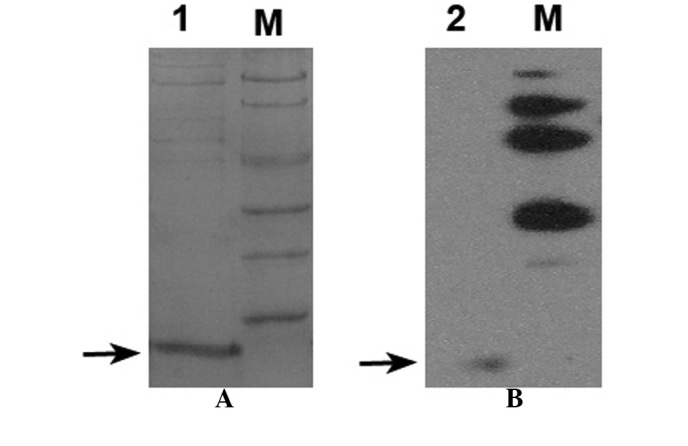
Mutated ISRAA gene. Mutated ISRAA was synthesized by site directed mutagenesis in which the predicted active site was deleted from the ISRAA gene, cloned in an pUC57 vector, protein was expressed in pQE32 vector, purified and then the activity of the mutated ISRAA was tested on hPBMCs. Protein sequence, isoelectric point (PI) and molecular mass (MW) are demonstrated as follows: PI/MW; 7.31/11955.0. Protein sequence: MRGSHHHHHHHGIRMAGETVLQGCPLCPDH AEGDRSPRIGGSQRQSPLLEVTHTQCCHLILSCLYVWCPVTQSLYGA PEQHSYTEVTSLQVIRILVNPSESANCLGKL. SDS-PAGE analysis of the mutated protein: (A) Lane 1, SDS-PAGE (4–20% gradient gel) of ISRAA-mutant protein (3 μg). (B) Lane 2, western blotting checking the mutated protein using anti-His antibody. Arrows indicate 11.955 kDa, the mutated protein on the SDS-PAGE and western blot analysis. Wild type ISRAA = 15 kDa. ISRAA, immune system-released activating agent; M, protein marker; hPBMCs, human peripheral blood mononuclear cells.